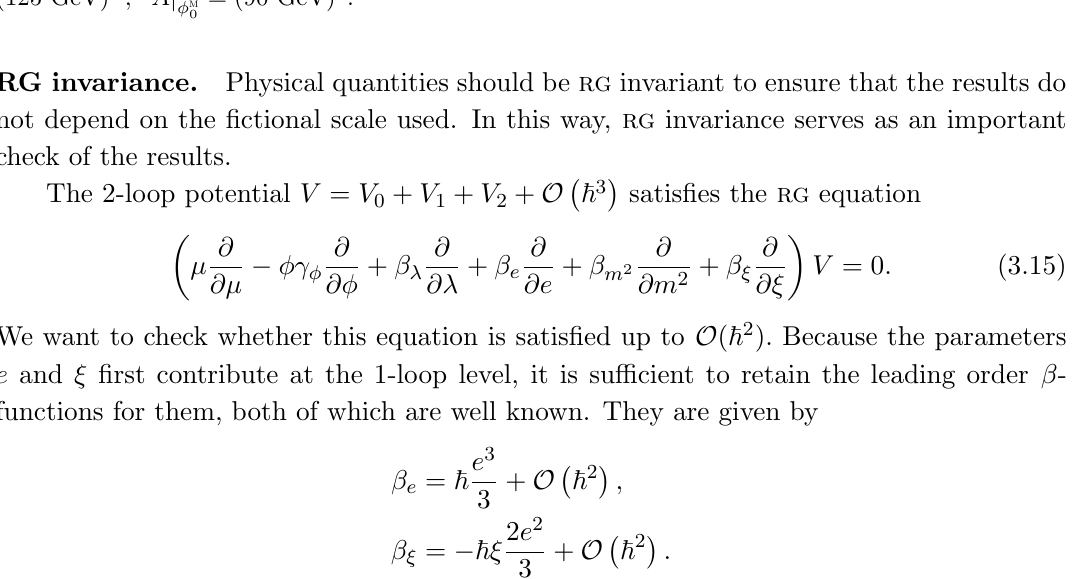
( (cid:30) ) + ~ 2 V h ( (cid:30) ), 1 2 = 246 GeV, H j = 0 (cid:30) m 0